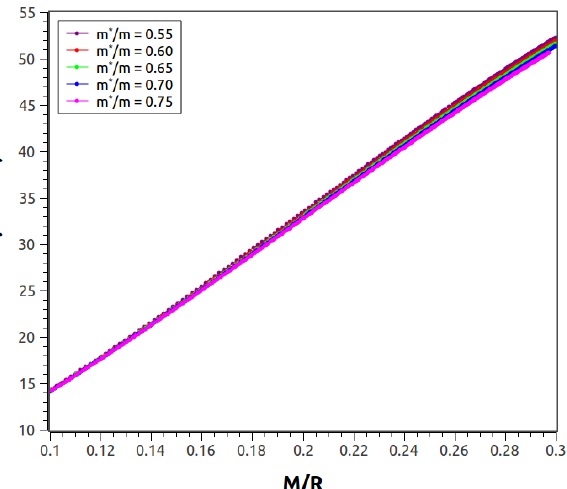
Figure 12. Scaled f -mode frequency ω M as function of stellar compactness C = M / R for varying m ∗ / m